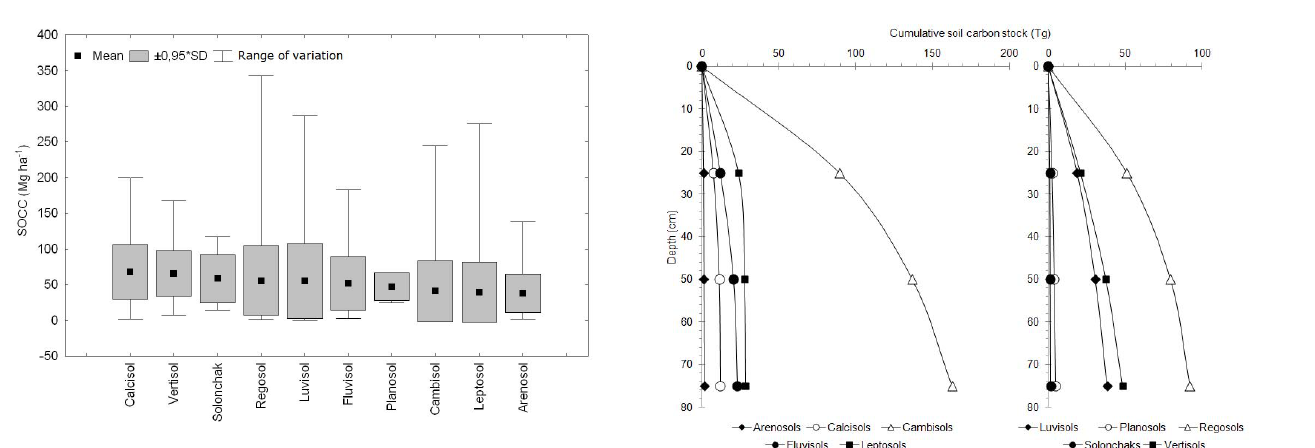
Fig. 2. Soil organic carbon content (SOCC) for the major soil groups in the study area. SD: standard deviation (0–75cm).